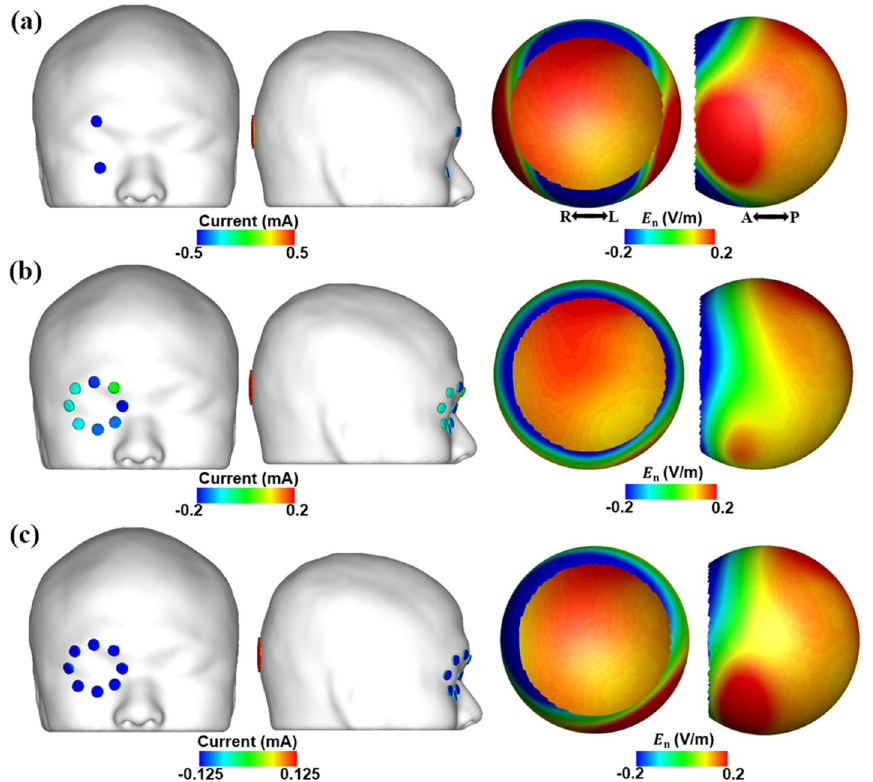
Figure 4. Injection current pattern and electric field distribution in the retinal surface when applying ( a ) conventional montage, ( b ) suggested montage with injecting the optimal injection currents, and ( c ) suggested montage with equally distributed injection currents. E n represents the electric field in the direction normal to the retina surface.